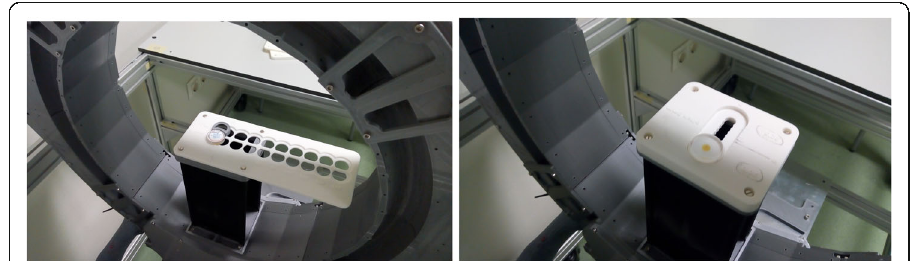
axis. Right, holder for the sensitivity